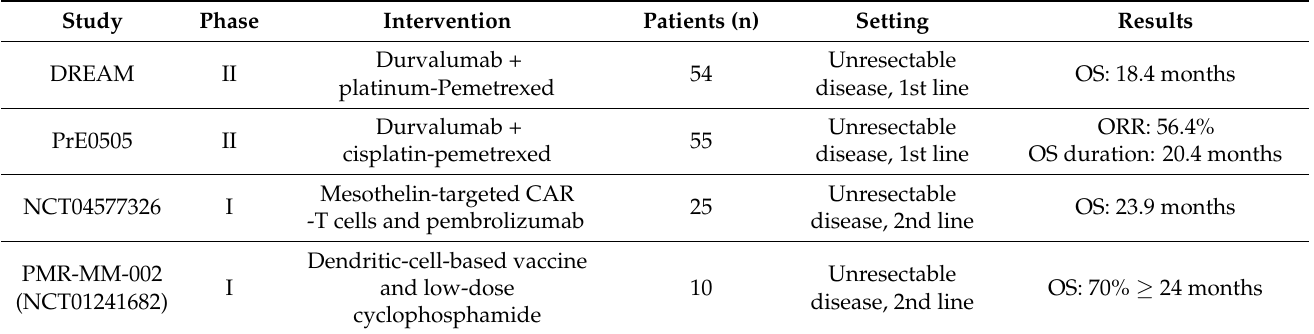
Table 3. Early phases results of promising approaches in